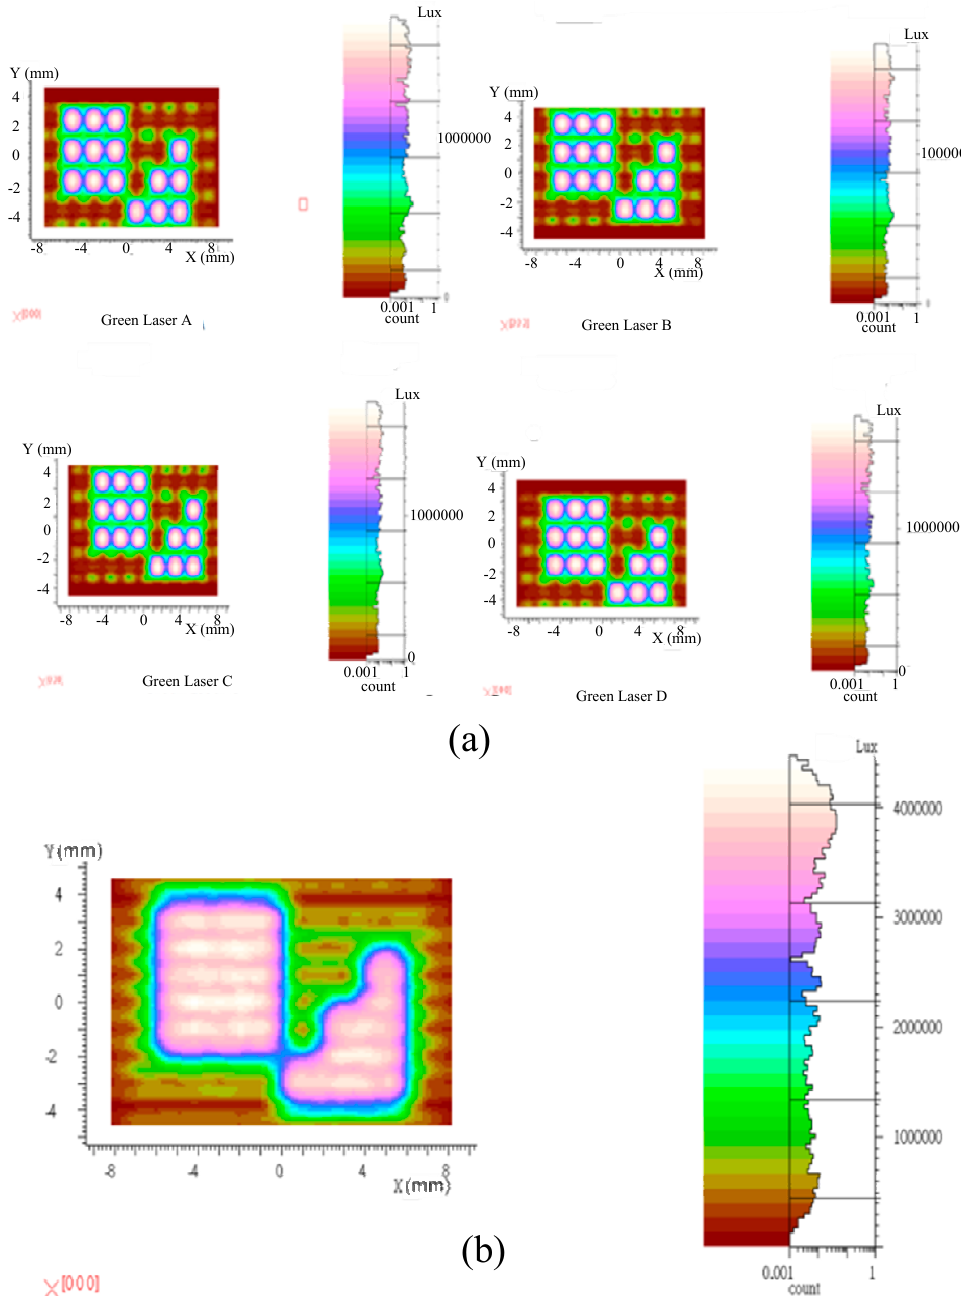
Figure 12. ( a ) Single green laser, displaying displacement map for local dimming (liquid crystal lens with pore size of 2.0 mm and a focal length of 9 cm). ( b ) Four green lasers, displaying compensation for light source micro scanning (liquid crystal lens with pore size of 2.0 mm and a focal length of 9 cm).